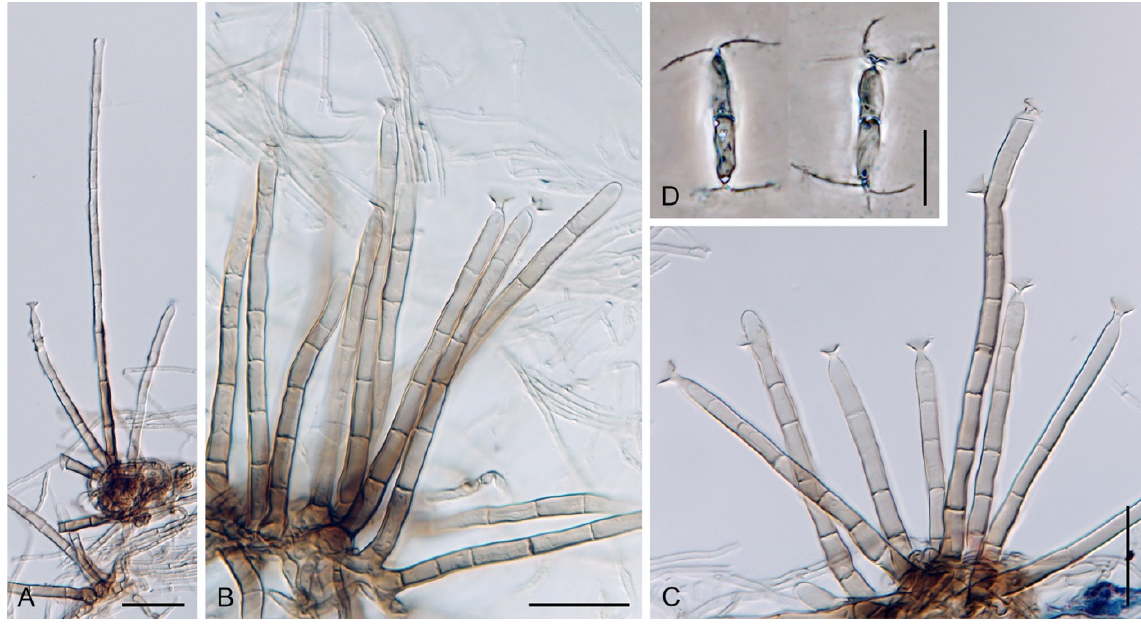
Figure 41. Stilbochaeta ramulosetula (IMI 313452 ex-epitype). ( A ) Seta with conidiophores ( B , C ) conidiophores ( D ) conidia. Images: ( A – C ) on CMD after 5 months. Scale bars: ( A ) 25 μ m; ( B , C ) 20 μ m; ( D ) 10 μ m.